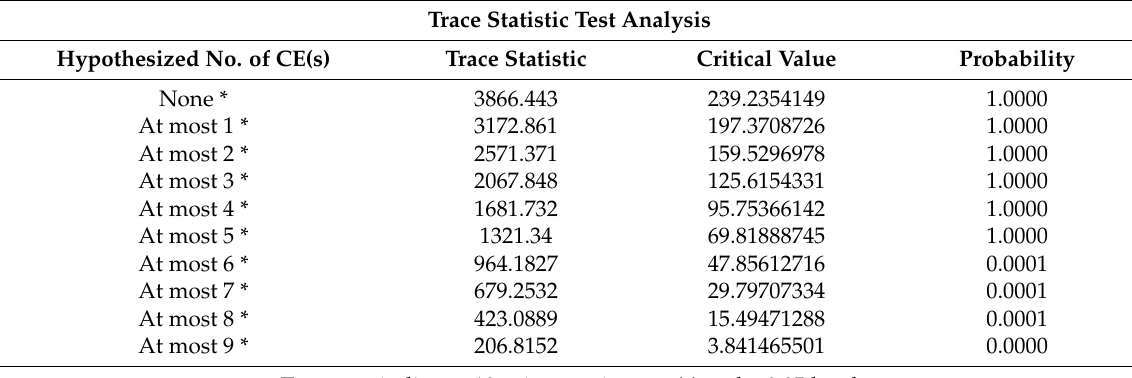
Table 3. Results from Johansen’s cointegration analysis: Trace